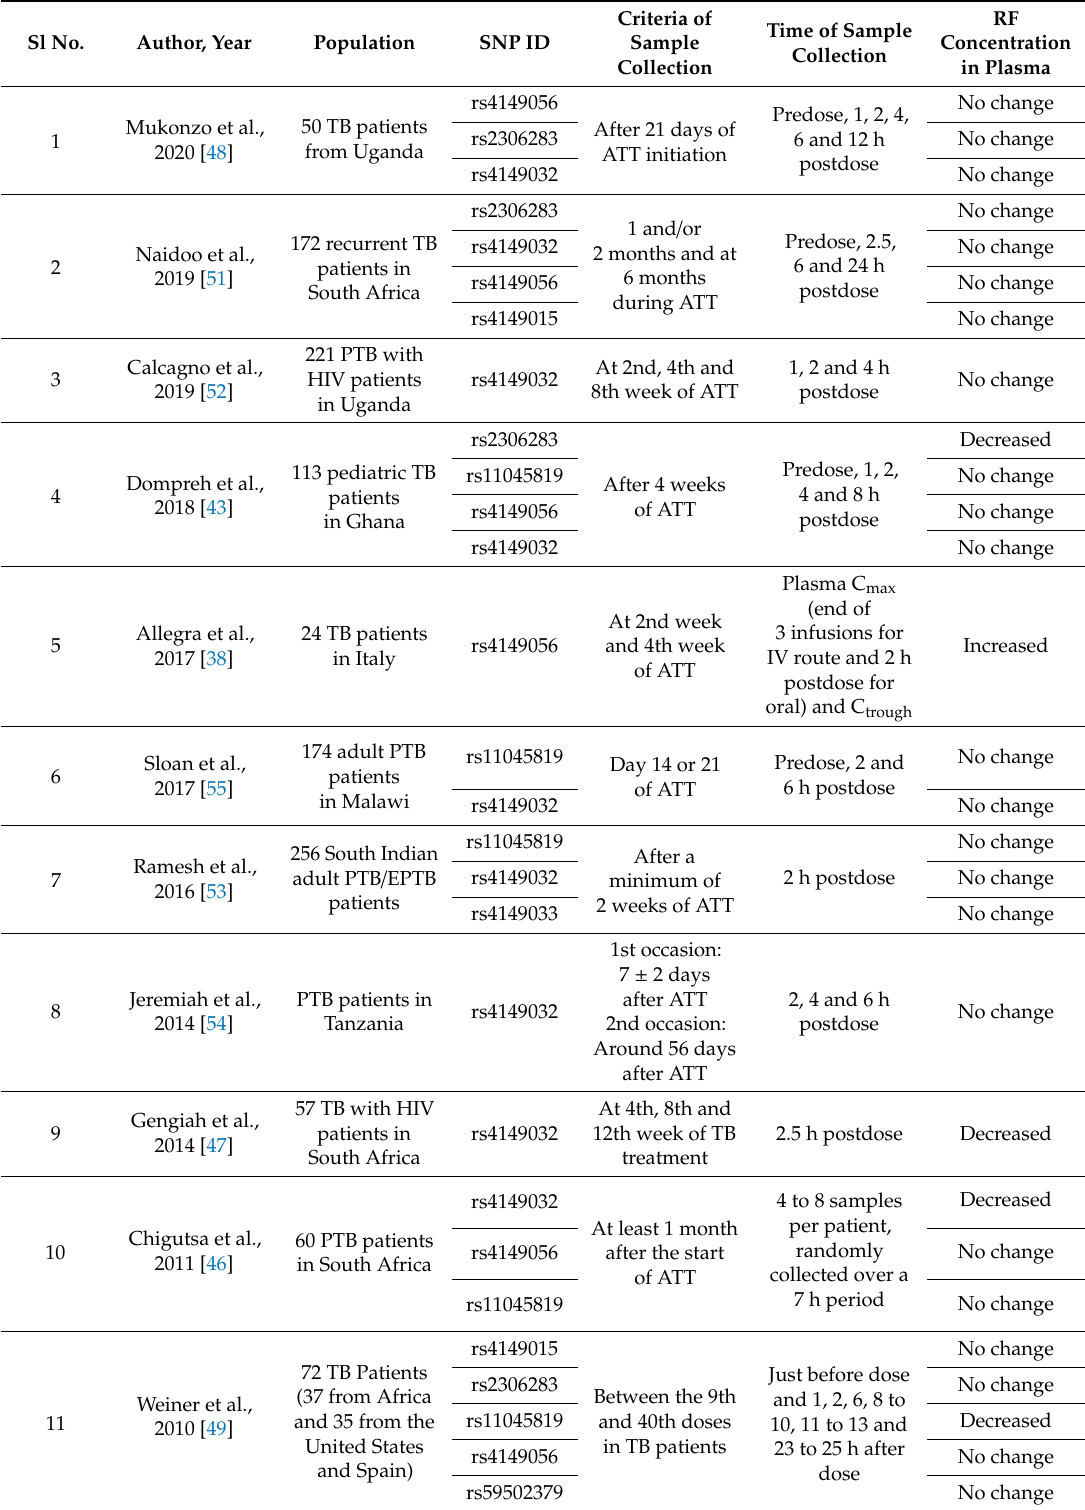
Table 1. Influence of SLCO1B1 genetic variants on plasma RF levels. Sl